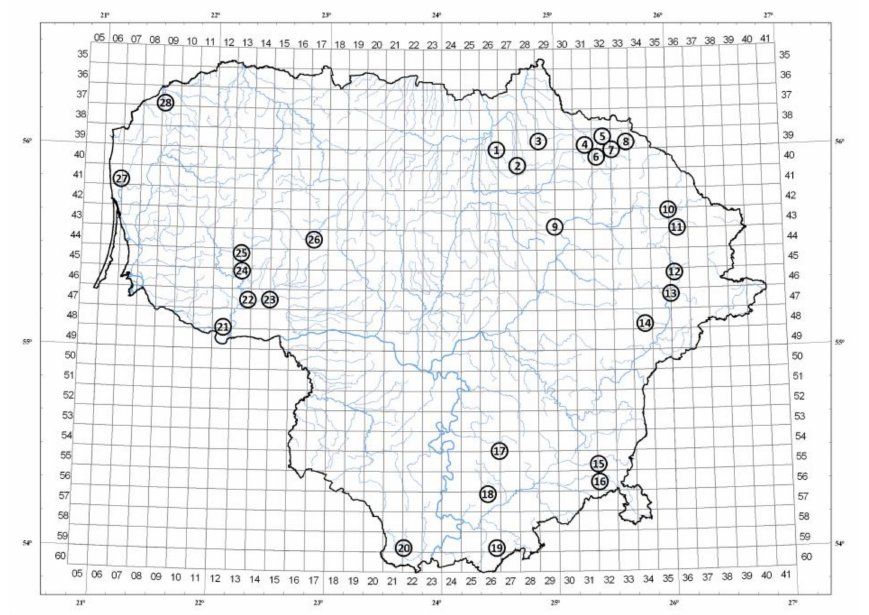
Figure 1. Collecting locations of lingonberry samples in Lithuania. Assignments are indicated in Table 1. Table 1. Geographical coordinates and edaphic characteristics of the lingonberry collecting locations in